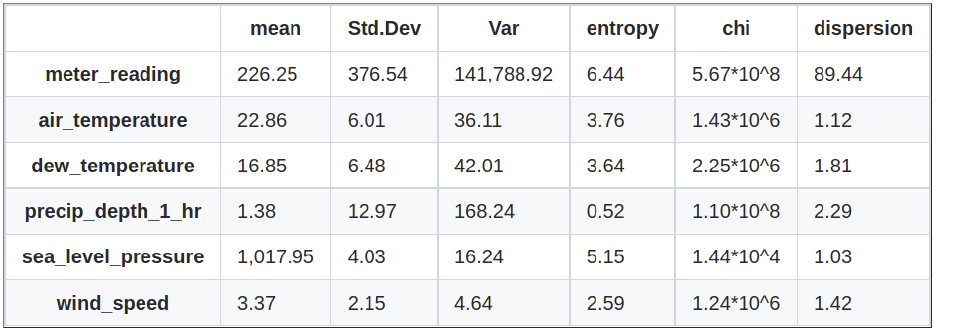
Figure 11. Statistical measures for selected